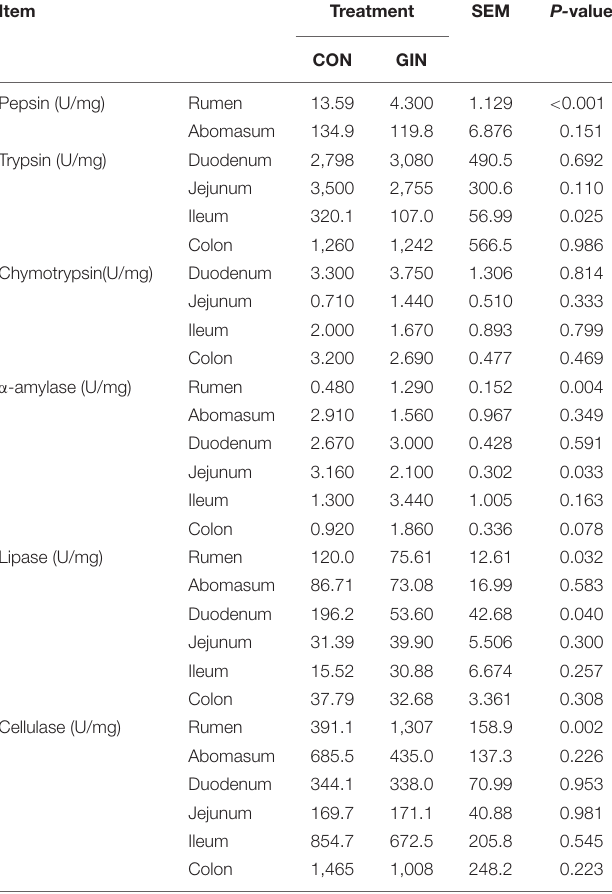
TABLE 3 | Activity of gastrointestinal digestive enzymes of lambs infected with Haemonchus contortus . Item Treatment